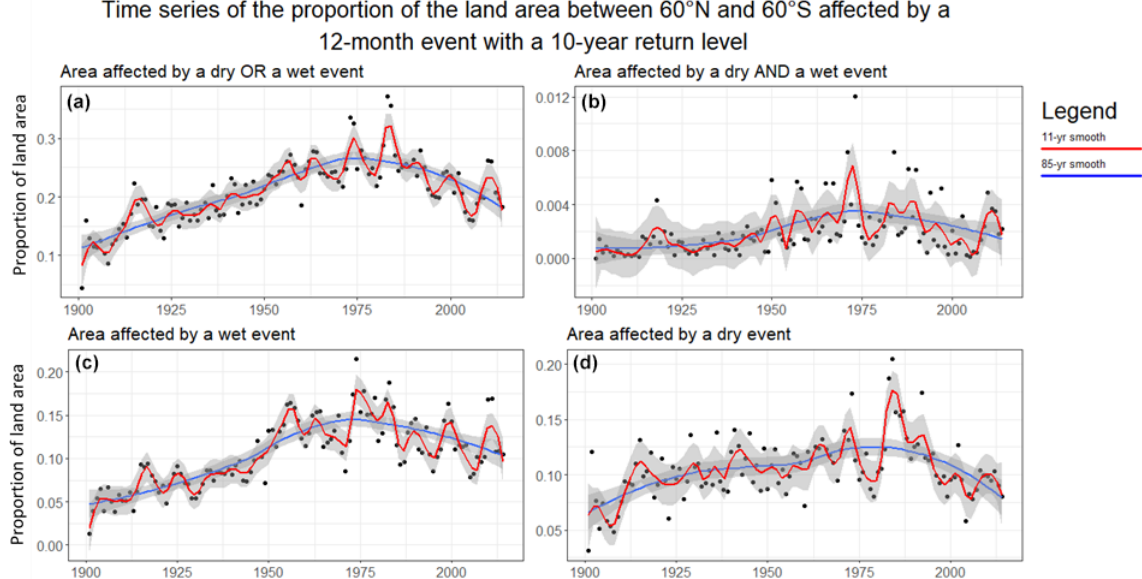
Figure 3. Proportion of global area affected annually by exceedance of the 10-year return level of the 12-month SPEI index for wet or dry (a) , wet and dry (b) , wet (c) , and dry area (d) events with 95th confidence interval in shaded